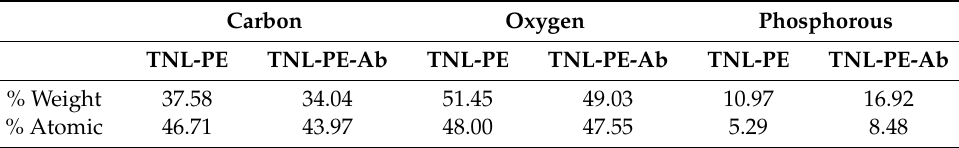
Figure 3. Cryo-TEM images: pink color and sky blue color arrow indicate small unilamellar vesicle (near about 50 nm in diameter) and unilamellar vesicle (near about 100 nm in diameter), respec- tively. Green color arrow represents two unilamellar vesicles fused with each other.